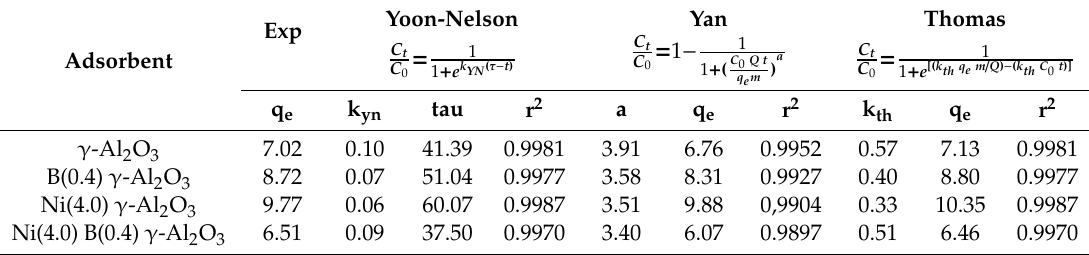
Table 3. Kinetics parameters obtained by the three models studied for